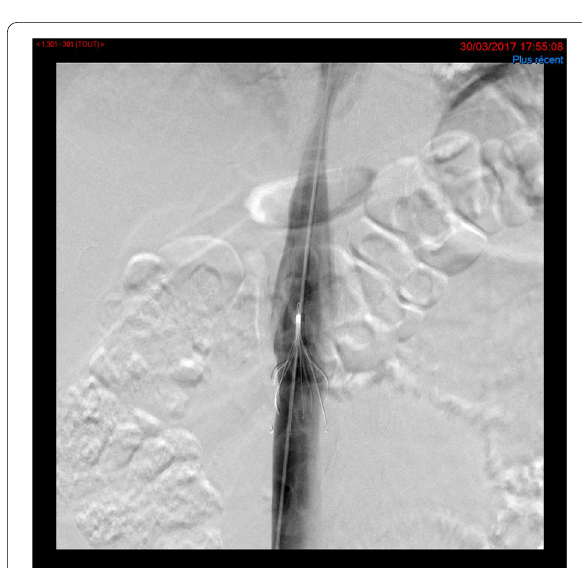
Fig. 3 Anterioposterior view of snare manipulation to remove the filter. The patient was referred 90 days after implantation for